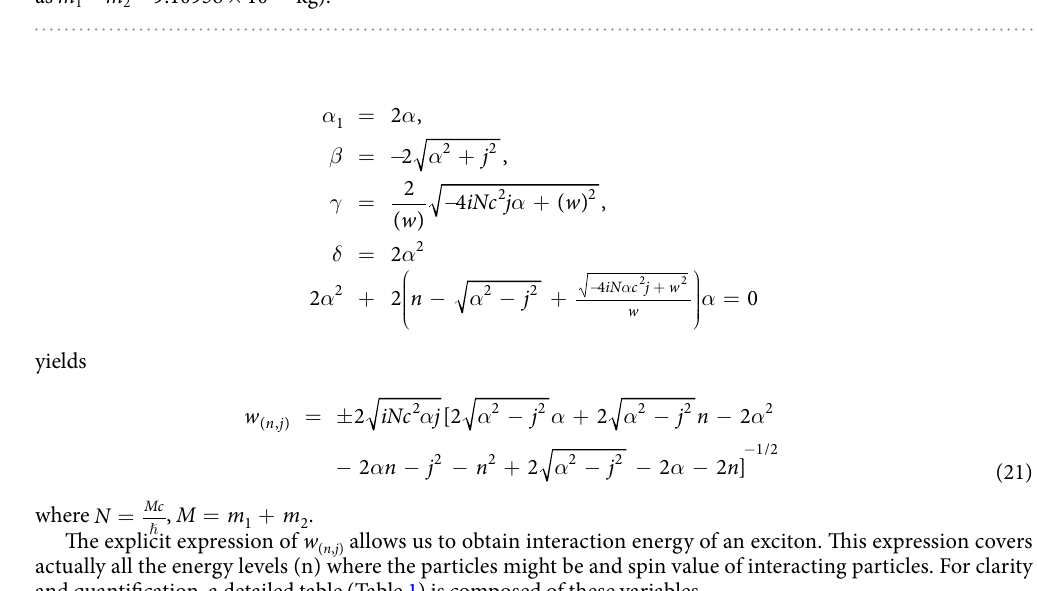
Table 1. Interaction energies for an exciton. (The masses of electron and hole ( m 1 and m 2 ) are taken to be equal as m 1 = m 2 = 9.10938 × 10 − 31